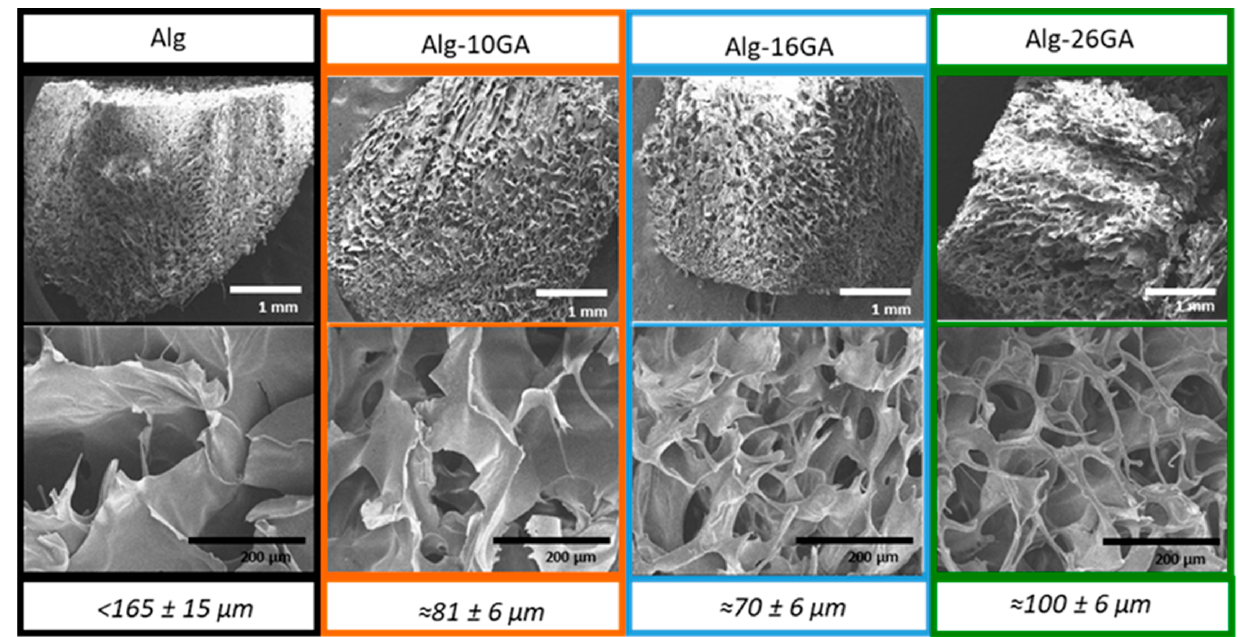
Figure 5. SEM micrographs of cross-linked alginate–gum arabic composites with 1 mm and 200 µm magni fi cations.